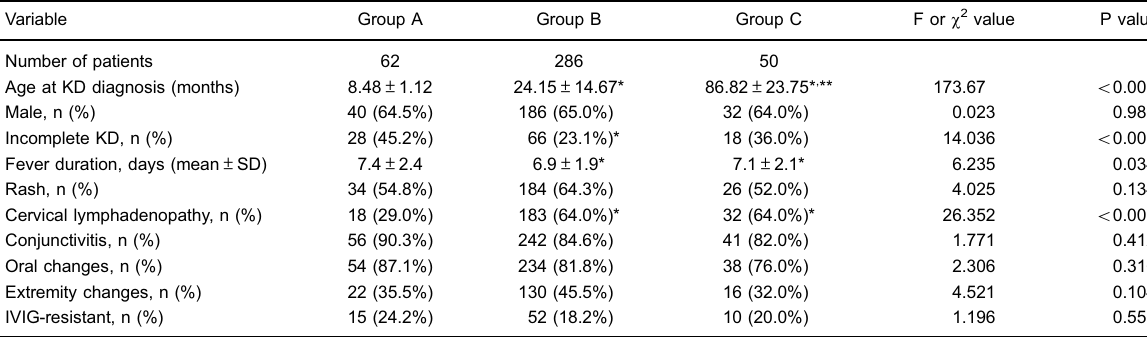
Table 1. Clinical parameters in the different Kawasaki disease (KD) age